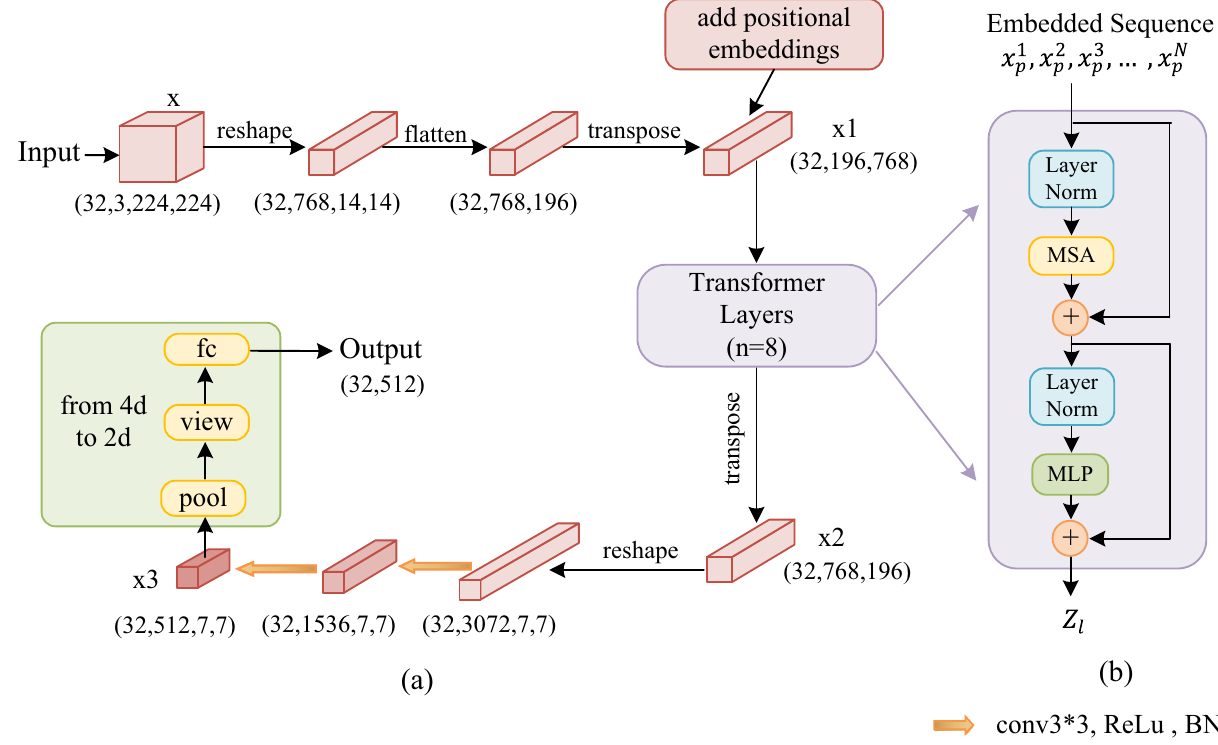
Figure 4. The Edge Feature Extraction (EFE) module. ( a ) The edge feature information extraction process. ( b ) The Transformer encoder module. Transformer layers is represented by n. The paper uses 4-layer or 8-layer Transformers, that is, n = 4 or n = 8. Each Transformer layer includes Layer Norm, MSA and MLP. (Created by ‘Microsoft Office Visio 2013’ https:// www. micro soft. com/ zh- cn/ micro soft- 365/ previ ous- versi ons/ micro soft- vision-